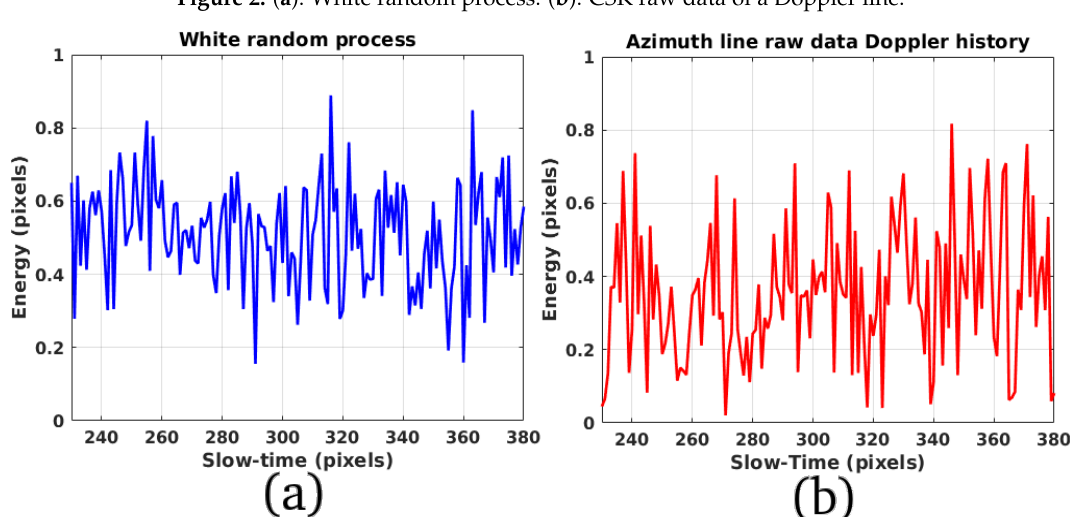
Figure 3. ( a ): Particular of the white random process. ( b ): CSK raw data of a raw Doppler line.